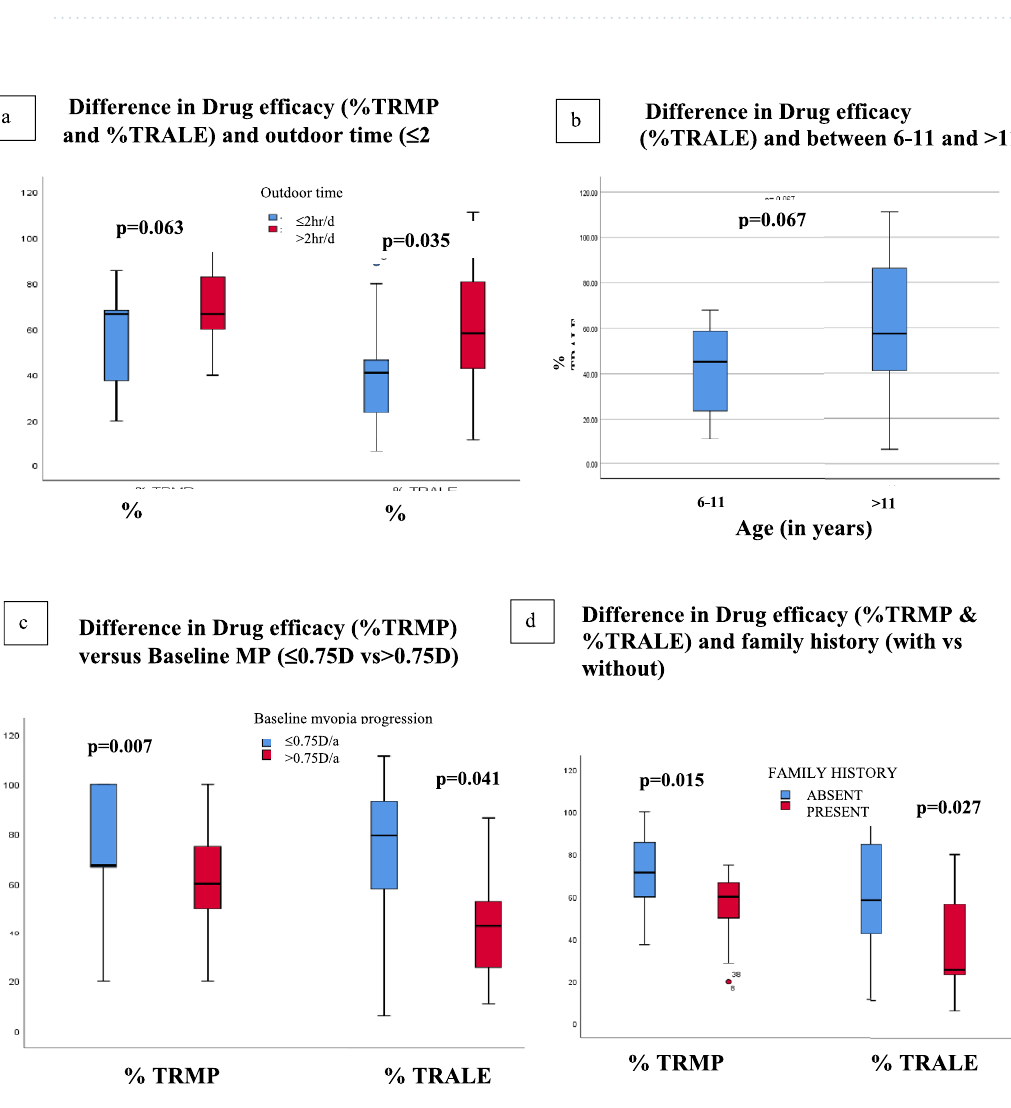
Figure 4. Box-whisker-plots showing the difference of %TRMP and %TRALE between groups: ( a ) with outdoor ≤ 2 h/day vs > 2 h/day; ( b ) age 6–11 years vs > 11 years ( c ) BMP) ≤ 0.75 D/annum vs > 0.75 D/annum ( d ) with family history vs without family history. ( D Dioptres, BMP baseline myopia progression, %TRMP Percentage reduction in Myopia progression in treatment eyes compared to control eyes, %TRALE percentage reduction in axial length elongation in treatment eyes compared to control